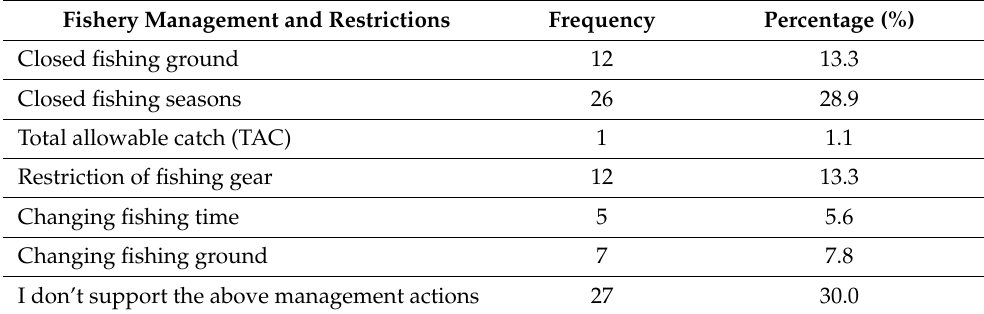
Table 5. Fishers’ support for fishery management measures and restrictions in the MPA for the Chinese white dolphin ( n =